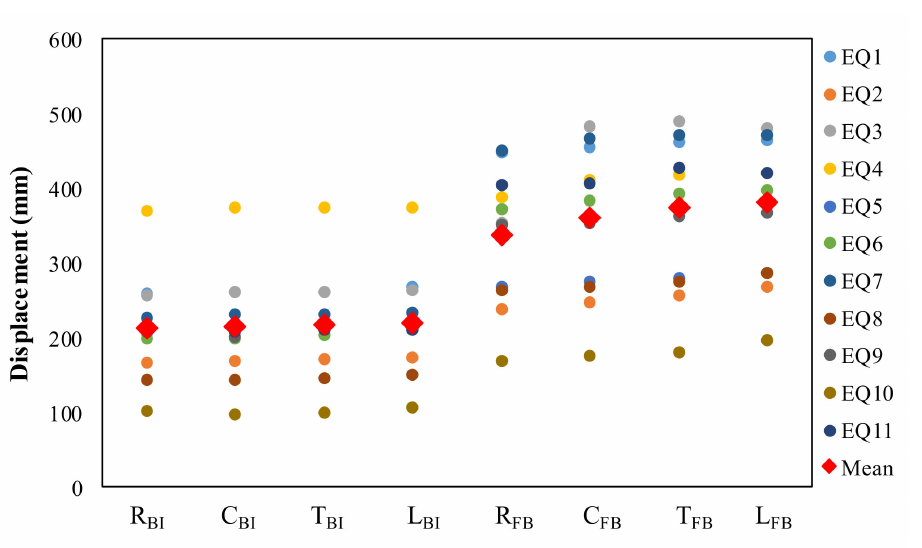
Figure 17. Roof displacements for isolated- and fixed-base R, C, T, and L models.